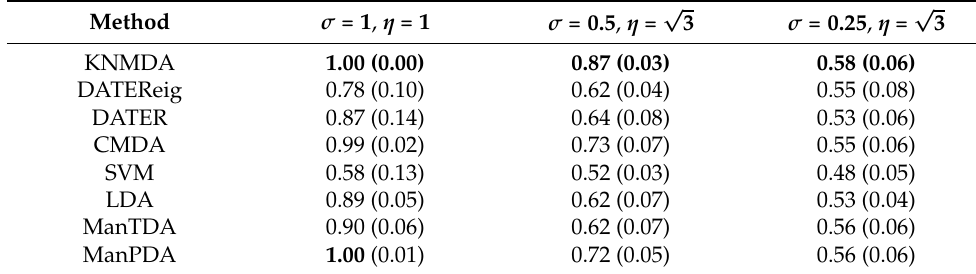
Table 3. HOSVD data. Different columns report AUC (and standard deviation) for decreasing levels of discriminability of the classes. The bold values represent the best performance for each column.